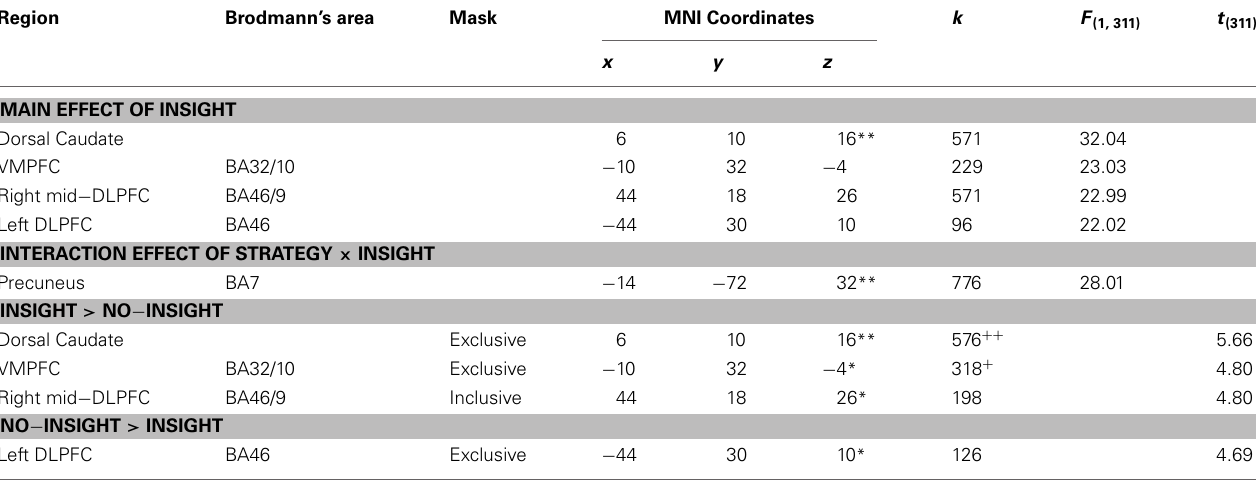
Table 2 | Results of Three-Way Factorial ANOVA (Identity × Strategy × Insight). Region Brodmann’s area Mask MNI Coordinates k F (1,